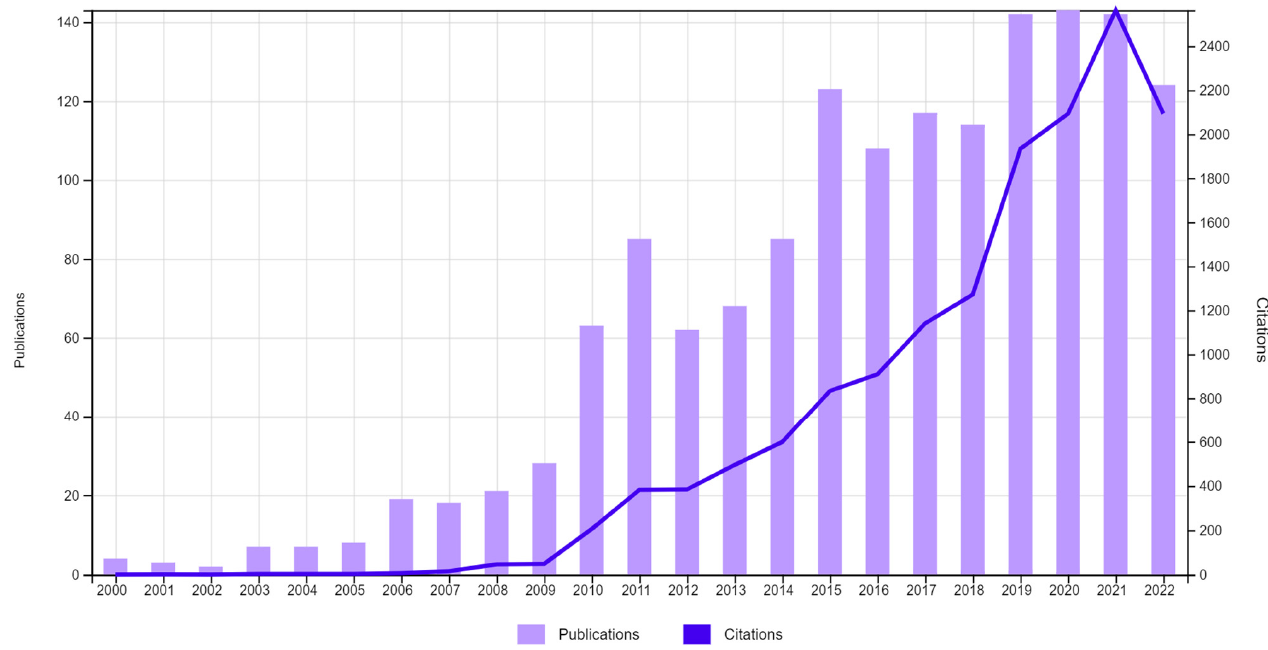
Figure 2. Number of health tourism publications from 2000–2022. Source: own elaboration based on the dedicated database.